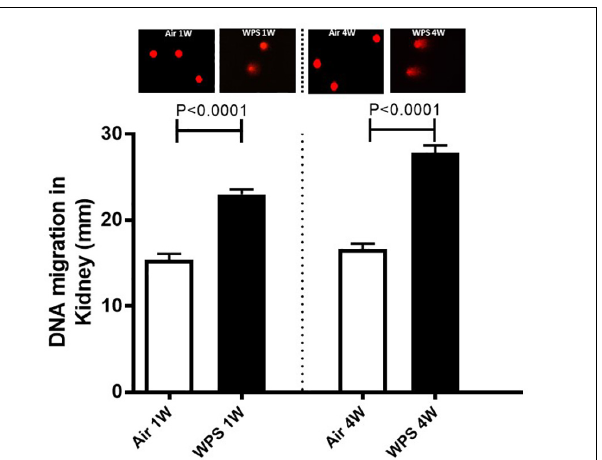
FIGURE 7 | DNA migration (mm) in the kidney tissues assessed by Comet assay in mice at the end of the 1-week and 4-week exposure periods to air (control) or water-pipe smoke (WPS). Images illustrating the quantification of the DNA migration by the Comet assay under alkaline conditions in mice at the end of the 1-week and 4-week exposure periods to air or WPS. Data are mean ± SEM ( n = 5).